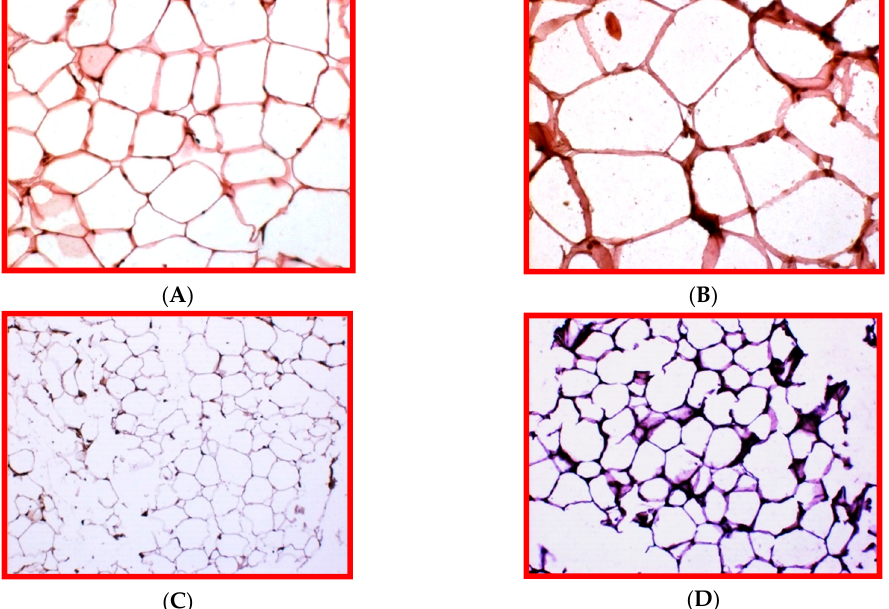
Figure 1. Epididymal white adipose tissue (eWAT) in male C57BL6/J mice fed a standard diet (STD) or a high fat diet (HFD) for 16 weeks. ( A ) Representative histological picture of adipocytes under standard rodent diet; ( B ) Enlarged adipocytes under an obesogenic treatment stained by H&E; ( C ) GRP78 immunostaining is weak in STD fed mice; ( D ) GRP78 immunoreaction is intense in HFD fed mice associated to crown-like structures, a sign of chronic ER stress linked to inflammation. A – B , Original Magnification = 200 × ; C – D , Original Magnification = 100 ×.